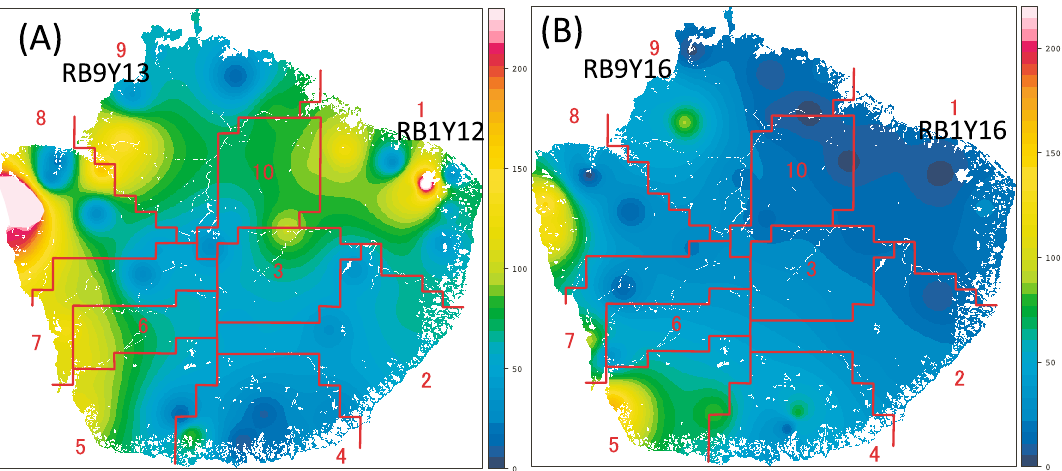
Figure 1. A contour map of estimate Yaku sika population density in 2013 ( A ) and 2016 ( B ). The numbers on the maps indicate the IDs of the ten areas separated by river boundaries (RB). Samples used in this study were obtained from following areas on the map; RB9Y13, RB9Y16, RB1Y12, and RB1Y16. Color keys show the estimated deer density as the number of deer individuals per km 2 . Redrawn from figures in Kagoshima Prefecture Nature Conservation Division 33 under permission of Kagoshima